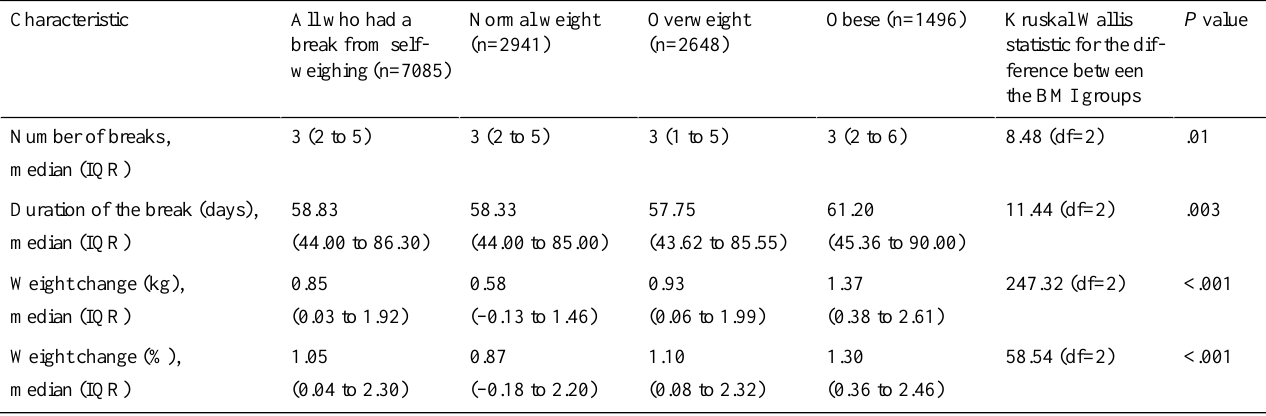
Table 2. The numbers of breaks in self-weighing, their durations, and the subsequent weight change among all study participants who had a break from self-weighing and in the 3 BMI